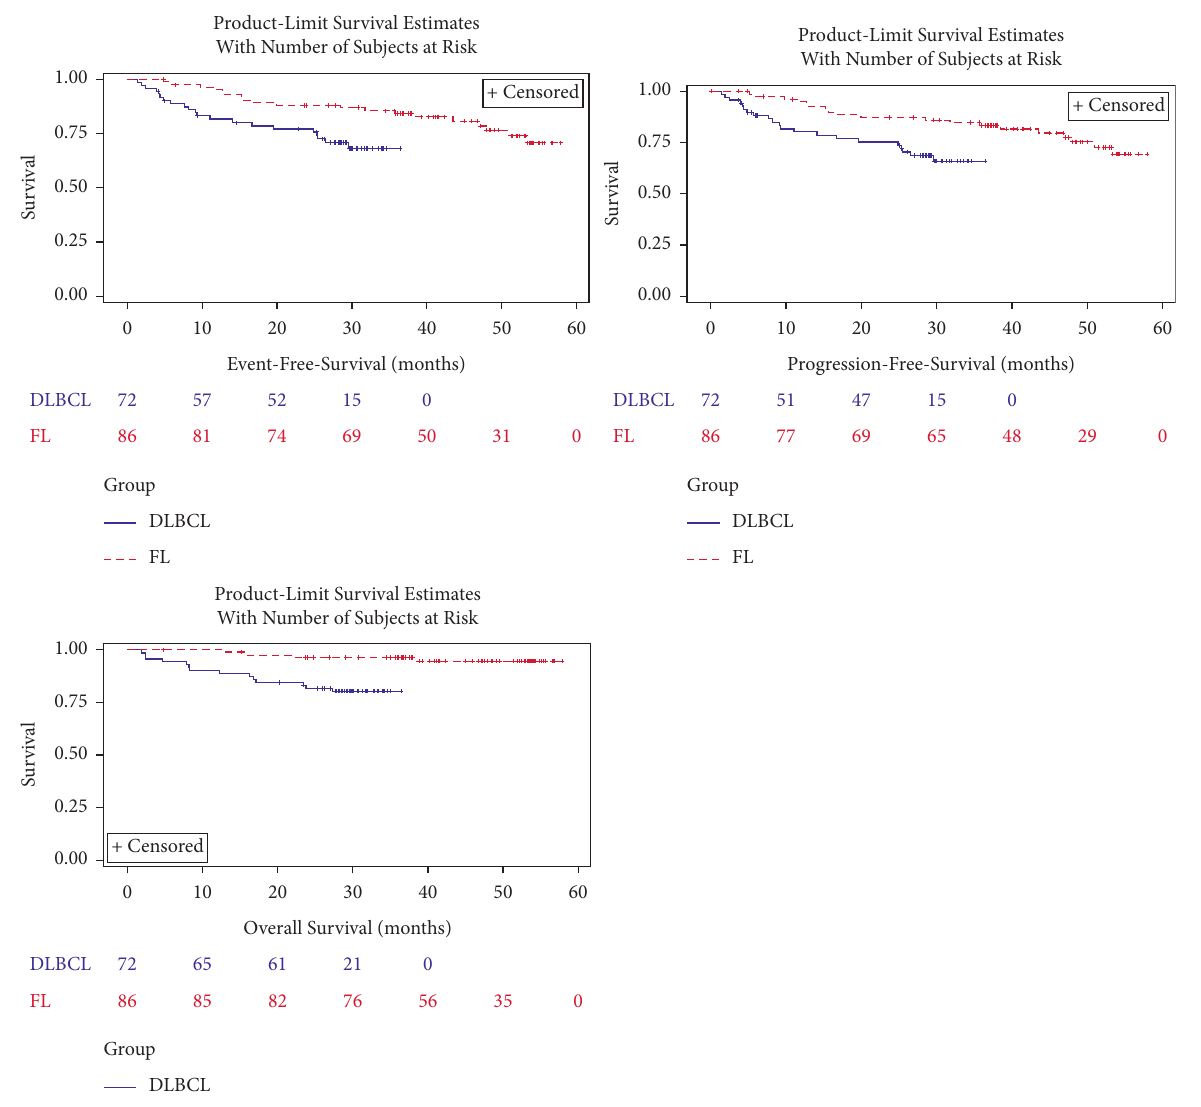
Figure 1: Kaplan–Meier estimate of time to event endpoints (EFS, PFS, and OS). DLBCL:diffuse large B-cell lymphoma; FL:follicular lymphoma; EFS: event-free survival; PFS:progression-free survival; OS: overall